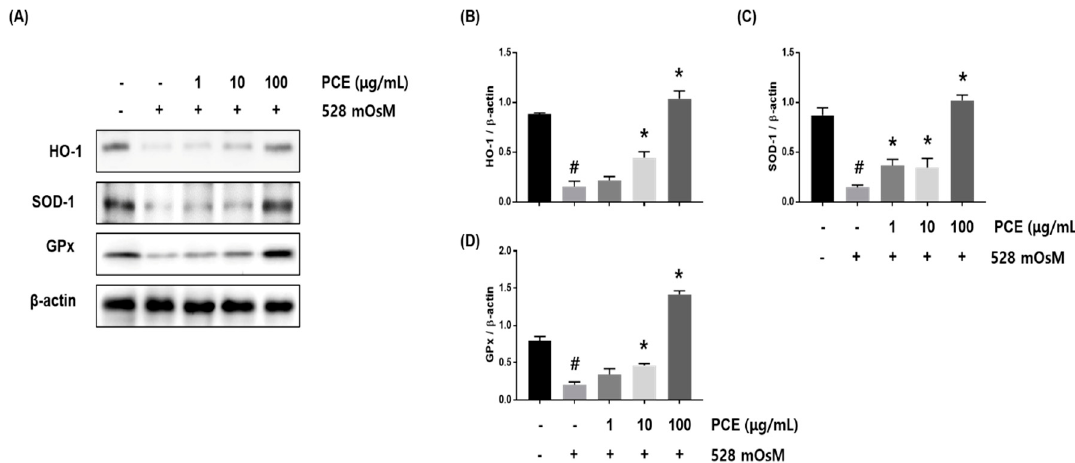
Figure 8. Effects of P. cuspidatum (PCE) on oxidative stress in hyperosmolar stress-induced human corneal epithelial cells (HCECs). HCECs were co-treated with the indicated concentrations of PCE and hyperosmotic media for 24 h. ( A ) The protein expression of HO-1, SOD-1, and GPx was analyzed by western blot analysis. β -actin was used as a loading control. ( B – D ) The relative intensities are expressed as the ratio of HO-1, SOD-1, and GPx to β -actin. Data are the mean ± SEM of three independent experiments for all groups. Means unlike letters in a column with differ significantly ( p < 0.05) # p < 0.05, significantly different from untreated group, * p < 0.05, significantly different from hyperosmotic-treated group.